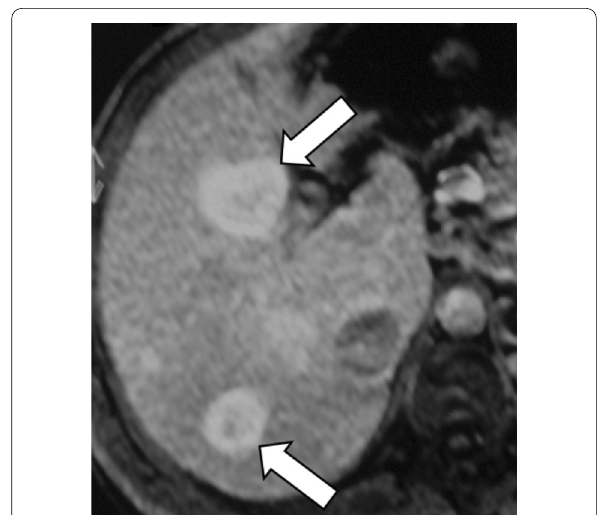
Fig. 7 A 41‑year‑old man with cavernous transformation of the portal vein and FNH‑like nodules. Gadoxetate disodium‑enhanced MRI shows two FNH‑like nodules (arrows) that are hyperintense in the hepatobiliary phase with central small hypointensity due to a central